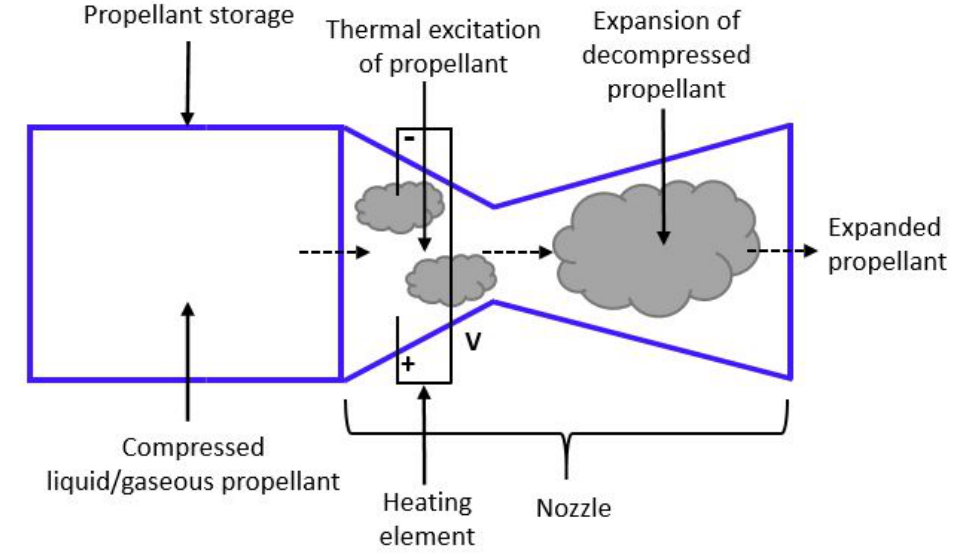
Figure 4. Schematic of a Resistojet